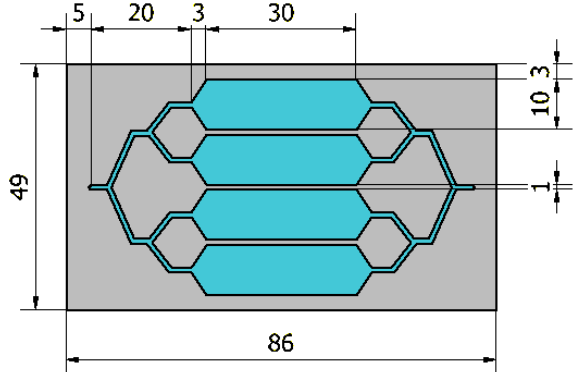
Figure 3. Dimensions of the optimized chip with 4 buffer tanks (given in